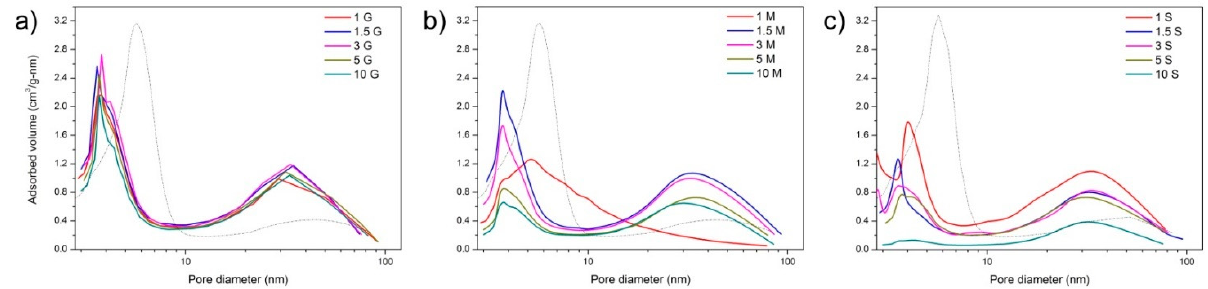
Figure 7. BJH pore distribution of the mesoporous hybrids functionalized with different percentage amounts of ( a ) GLYMO, ( b ) MEMO, and ( c ) MPTMS silane molecules at different concentrations (indicated in the labeling as % weight). Dash-dotted lines represent the BJH distribution of the unfunctionalized mesoporous hybrid particles.